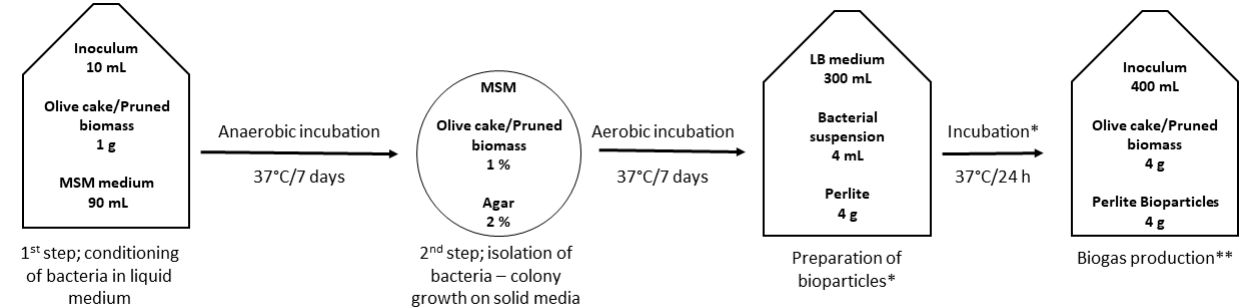
Figure 1. Experimental scheme for the preparation and testing of bioparticles made from perlite. * the bioparticle preparation was performed in two different setups; with aeration and anaerobic incubation with mixing (as described in chapter 2.4.). ** the biogas production was performed with different setups, as described in Table 1. Table 1. Experimental setup for monitoring biogas production.